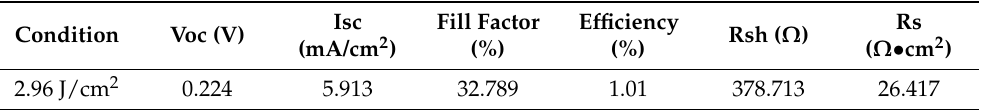
Figure 7. A J–V curve of the photo-sintered CZTS thin film solar cell. Table 3. The measured performance of the photo-sintered CZTS thin film solar cell with CdS and ZnS buffer layers.